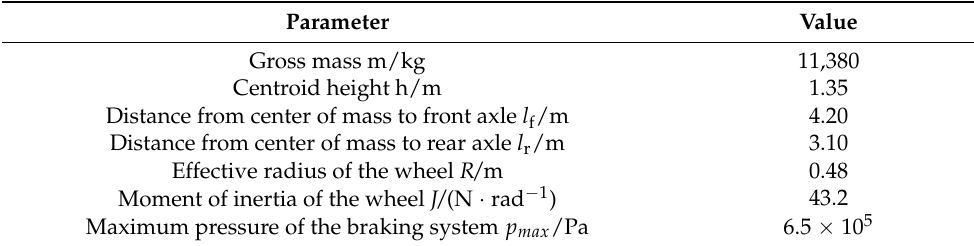
Table 3. Parameters of a two-axle commercial